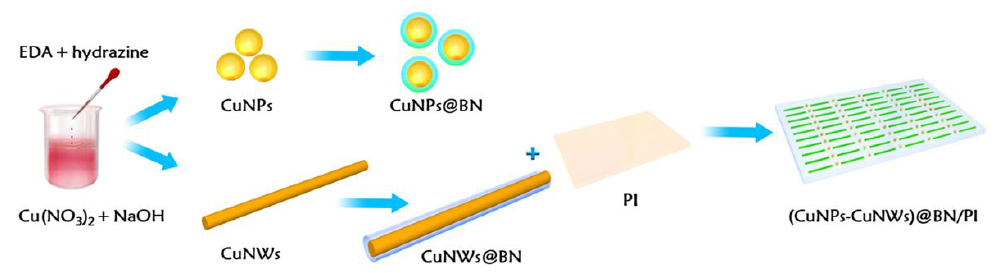
Figure 1. Preparation of multilayer-structured (CuNPs-CuNWs)@BN/PI film.